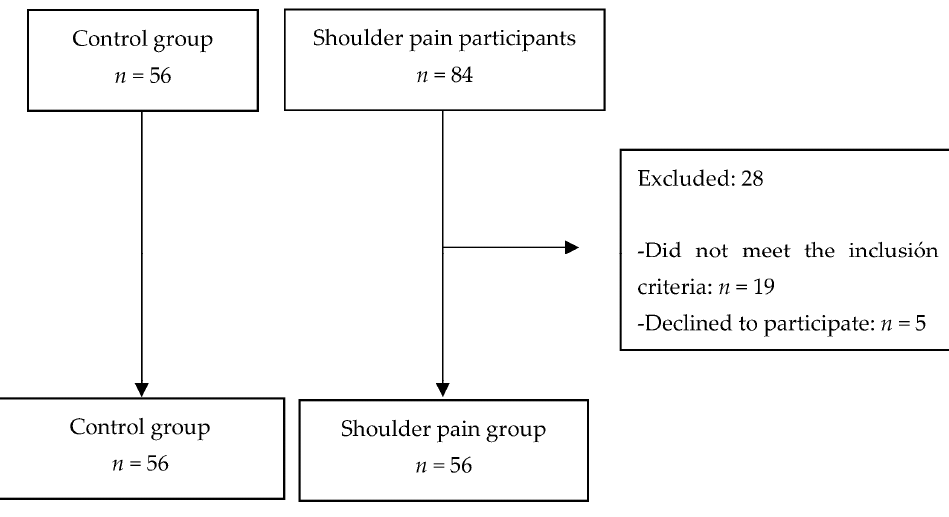
Figure 1. Flow chart.